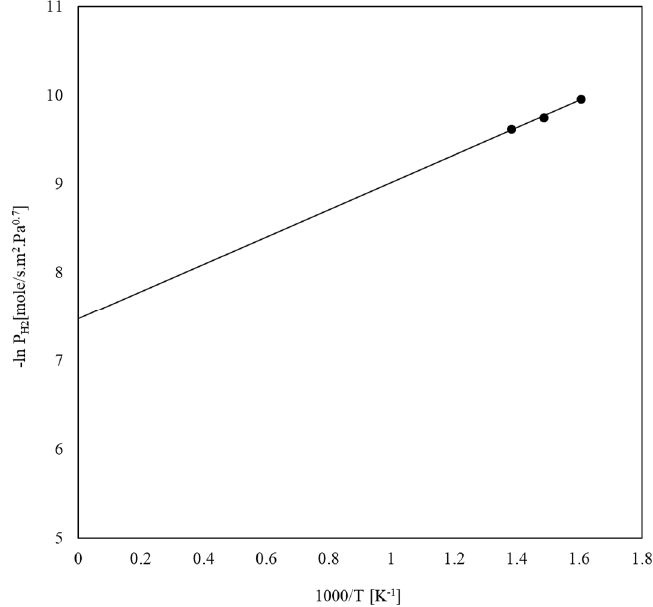
Figure 3. Arrhenius plot representing the permeation flux of pure H 2 in a Pd/Al 2 O 3 at a trans-membrane pressure of 100 kPa.